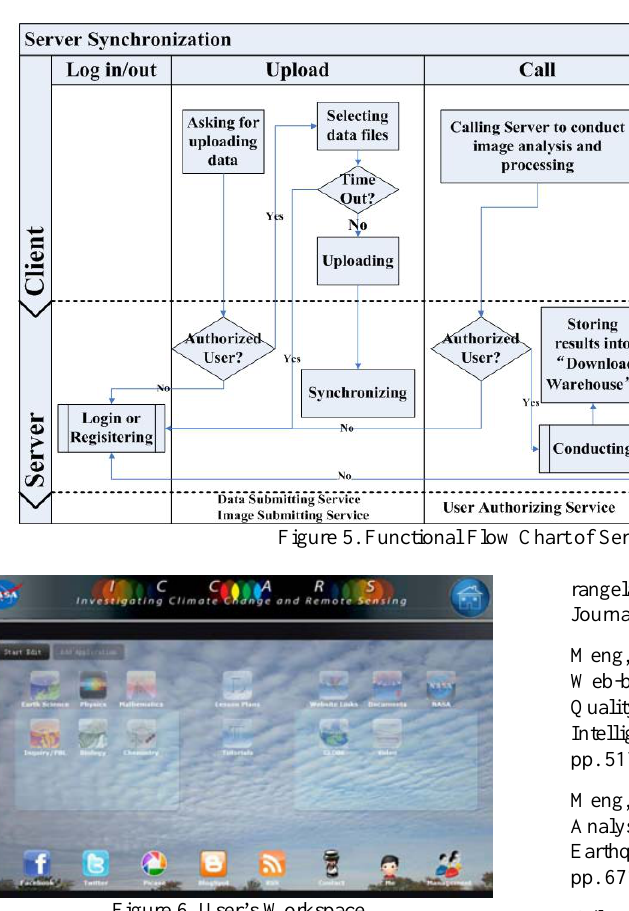
Figure 6. User’s